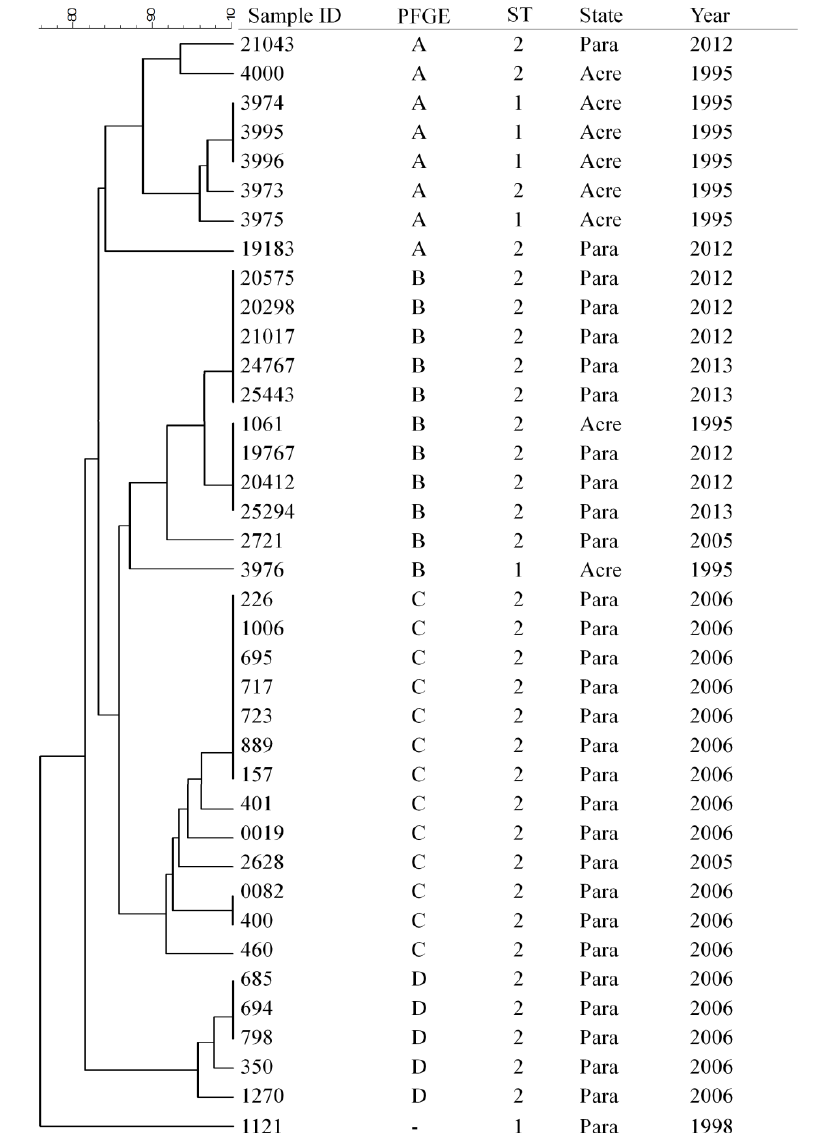
Figure 1. Dendrogram based on PFGE analysis demonstrating the genetic relatedness of 38 S. Typhi isolates from Acre and Pará States, Brazilian Amazon, in the period of 1995 to 2013.